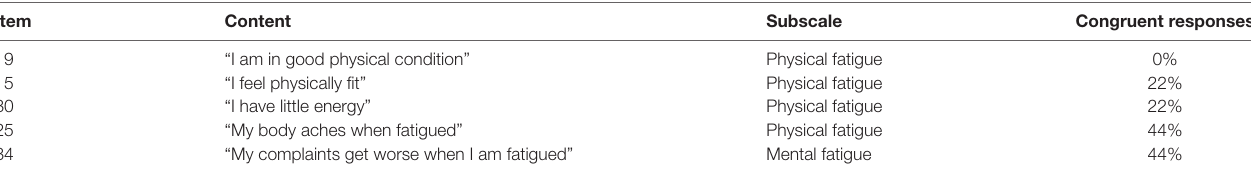
TABLE 3 | Problematic